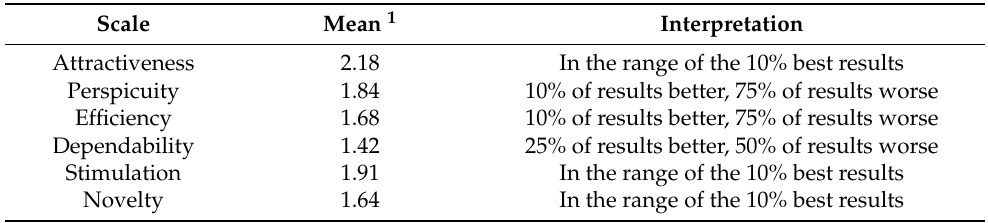
Table 2. Usability aspects of the self-fitting prototype in comparison with other